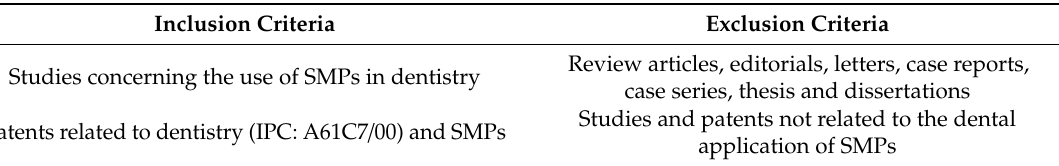
Table 2. Study Selection